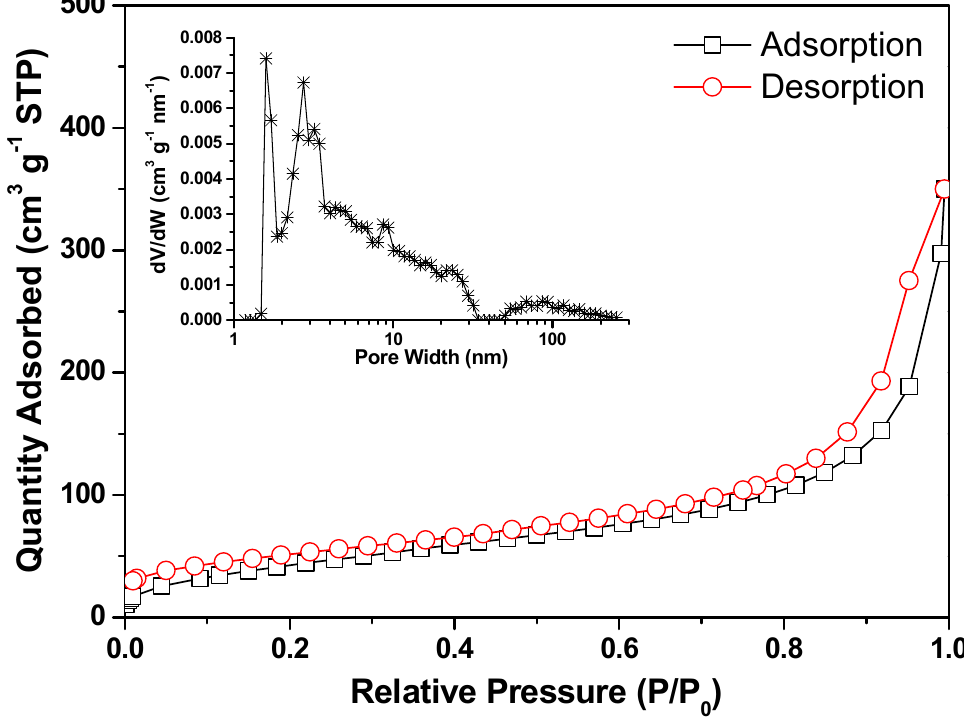
Figure 5. Nitrogen adsorption/desorption isotherms and the corresponding pore-size distribution (inset) of the Alg-C material.